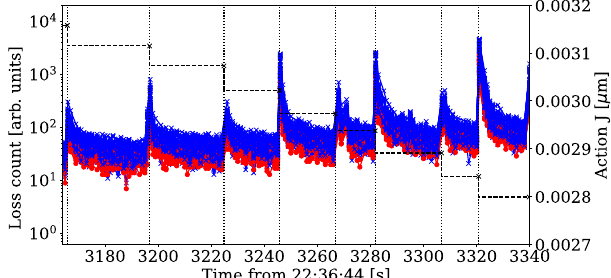
FIG. 12. Selected loss peaks resulting from the collimator steps. Data for beam 1 vertical scraping during fill 6052 with 2550b in 2017. The blue lines represent the bunches in the colliding trains while the red lines the 12 noncolliding bunches.